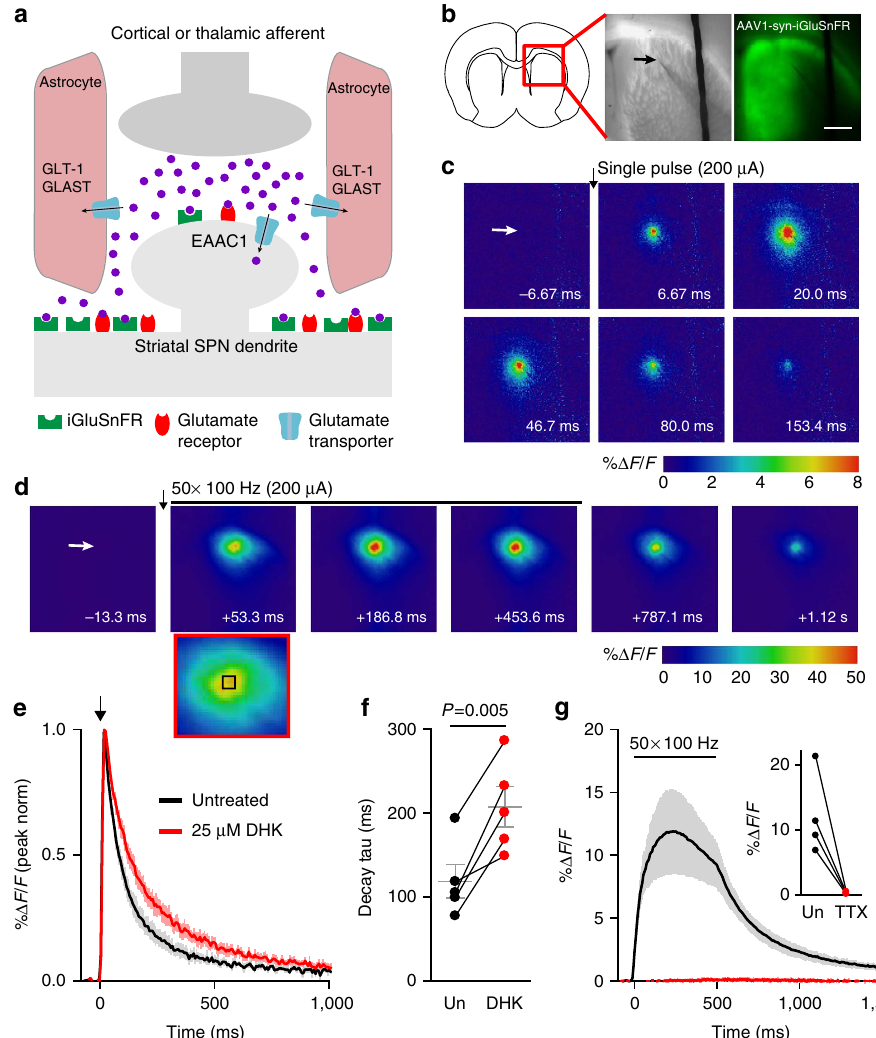
Figure 1 | Characterization of iGluSnFR responses in the dorsal striatum evoked by electrical stimulation. ( a ) Simplified schematic depicting the basic spatial organization of a glutamatergic synapse in the striatum. For the majority of the experiments in the present study, iGluSnFR was expressed exclusively on neurons to measure the relative time course of extracellular glutamate sensed by these neurons. Glutamate uptake can occur through glutamate transporter-1 (GLT-1) and glutamate-aspartate transporter (GLAST), located predominantly on astrocytes, or through excitatory amino acid carrier 1 (EAAC1), located predominantly on neurons 34 . ( b ) Typical experimental setup showing the extent of iGluSnFR expression in the striatum (shown in green on the right) and the approximate placement of the stimulating electrode to evoke local glutamate release (arrow). Expression was generally strong along entire dorsal striatum immediately ventral to the corpus callosum. ( c , d ) Representative heat-maps showing specific frames of representative iGluSnFR responses following a single stimulus at 200 m A ( c ) or 50 pulses at 100Hz (200 m A; d ). The red-bordered frame in d is a magnified view of the panel immediately above it, with a 4 (cid:2) 4 black box drawn to depict the region of interest corresponding to the region of maximal iGluSnFR signal that was used for quantification. ( e ) Grouped data ( ± s.e.m.) demonstrating the effect of dihydrokainic acid (DHK; 25 m M for 10min) on iGluSnFR decay tau. Each response was normalized (norm) to its peak to emphasize the slowing effect DHK has on iGluSnFR decay. DHK had no significant effect on response size (before DHK: 4.6 ± 1.7% D F/F; after DHK: 4.4 ± 1.9% D F/F, n ¼ 5, P ¼ 0.81, paired t -test). ( f ) Paired values for the experiments in e . In all the cases, 25 m M DHK resulted in a robust increase in iGluSnFR decay time (paired t -test). ( g ) Grouped data showing that iGluSnFR responses, even following high-frequency stimulation (50 pulses, 100Hz, 200 m A), were completely blocked by tetrodotoxin (TTX). TTX is shown in red, untreated (Un) is shown in black. Scale bar, 1mm in b and applies to all square panels in b , c and d pulse intensity did not enhance the proportional spread of suggesting that electrical stimulation evokes a wide radius of iGluSnFR signals from the central point of maximal release simultaneous glutamate release in this preparation, at least as (Supplementary Fig. 2a–f), suggesting that the iGluSnFR response detected by the 6.67 ms frame-rate used here. Thus, all the future radius is unlikely to represent glutamate diffusion originating analyses were restricted to the central region of release adjacent to from the area of maximal release. Furthermore, the rise and decay the stimulating electrode to optimize the signal-to-noise ratio. kinetics of iGluSnFR responses were found to be nearly identical regardless of whether the 4 (cid:2) 4 region of interest (ROI) was In situ glutamate clearance in YAC128 mice . Numerous groups placed in the region of maximal glutamate release or 500 m m have demonstrated a reduction in GLT-1 mRNA and/or protein away from this central release site (Supplementary Fig. 2g,h), expression that associates with a significant reduction in